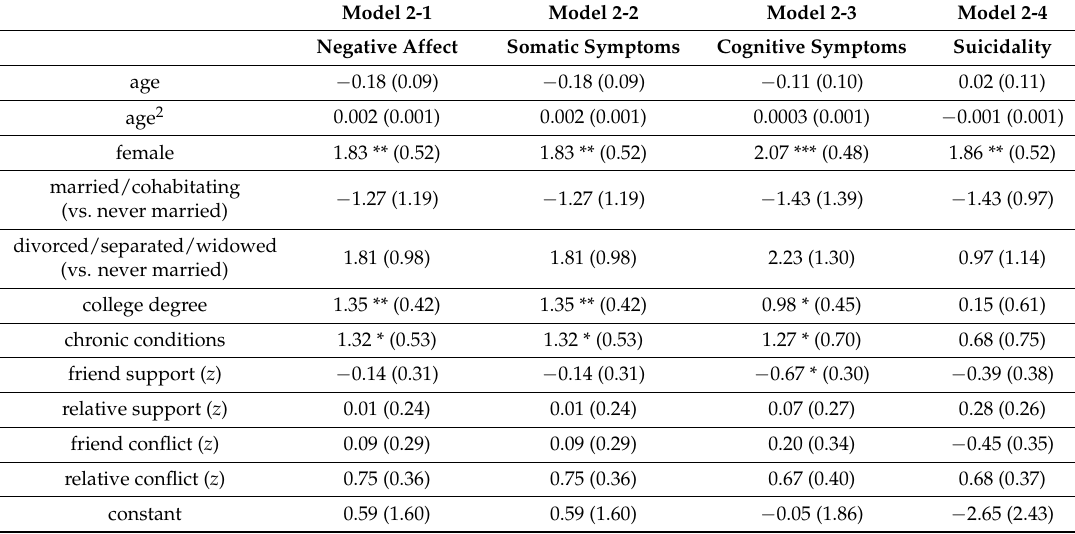
Table 7. Weighted Logistic Regression on Four Dimensions of Depression among US-born Chinese Americans.